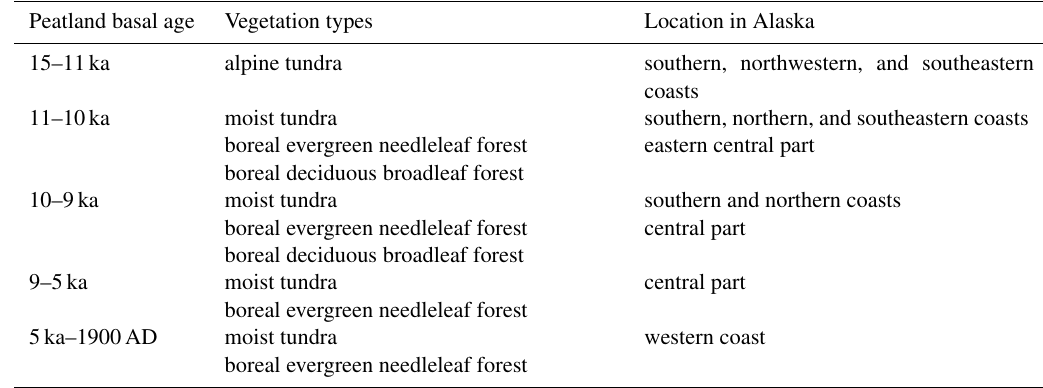
Table 4. Relations between peatland basal age and vegetation distribution. Peatland basal